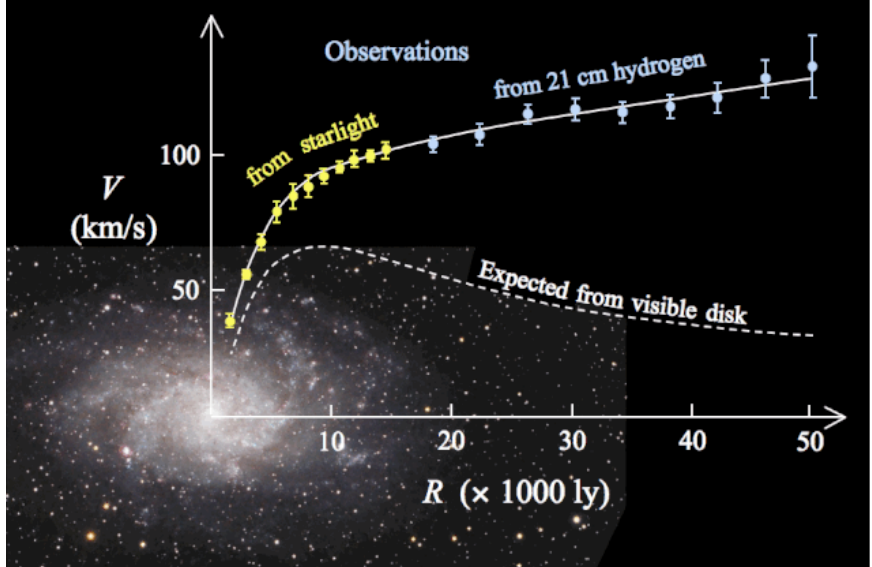
Figure 5. Rotation curve (km/s vs. light years) of the Spiral M33 obtained from optical and 21 cm data (points with error bars) compared with the RC expected from the luminous component (dashed line). The solid line is the RC model when a dark halo is included (see [142] for